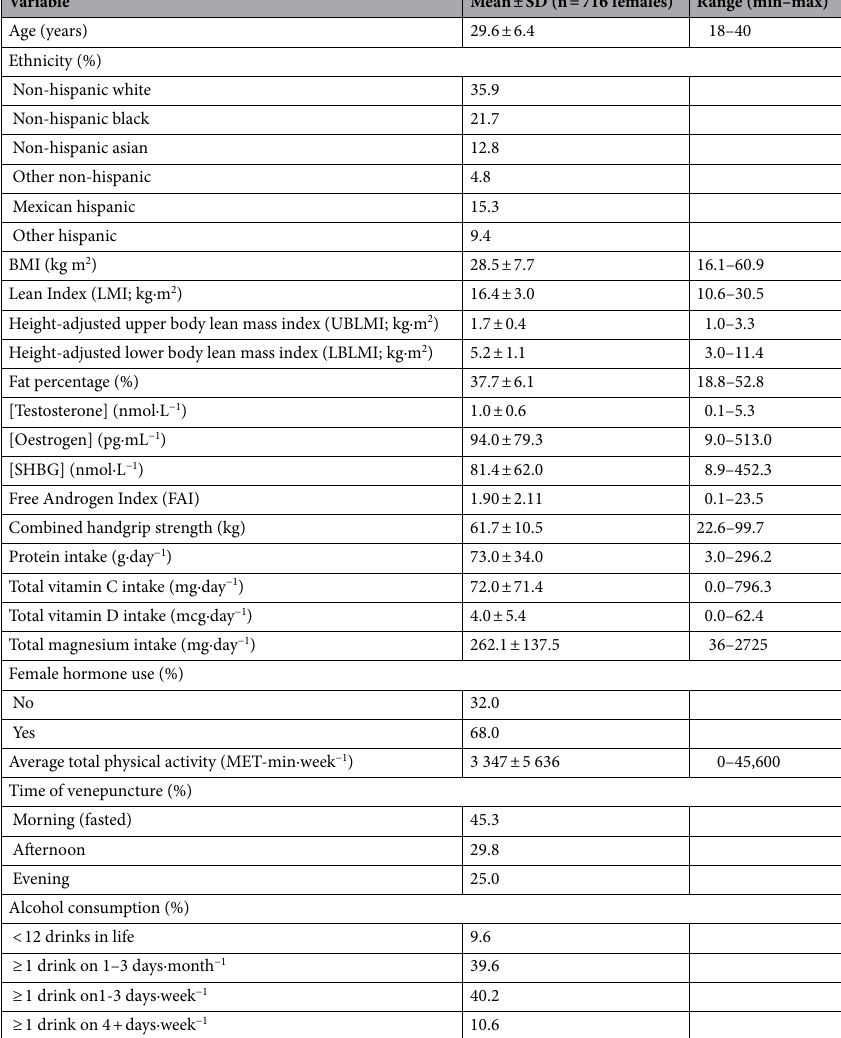
Table 1. Weighted characteristics of included females. Values are mean ± standard deviation. n = 716.